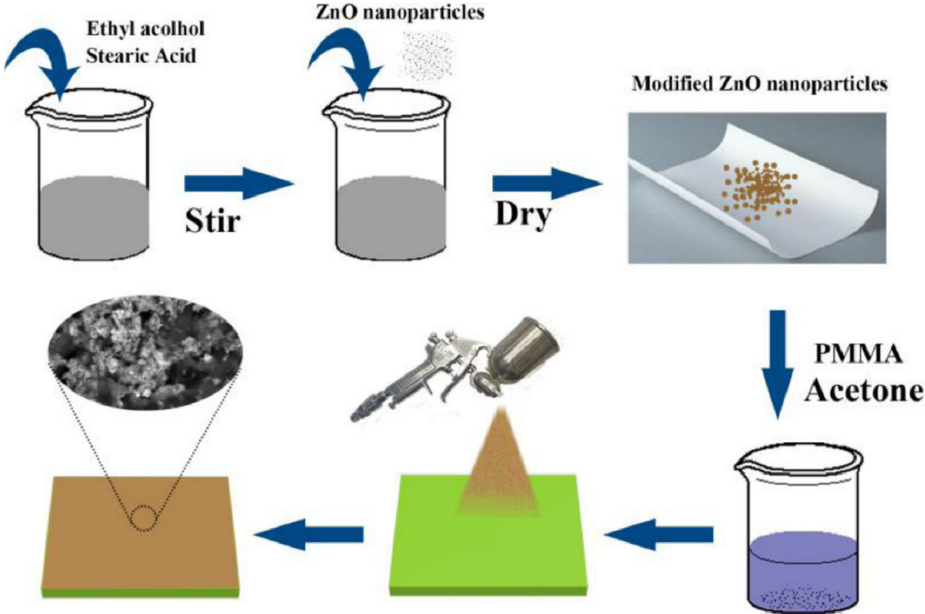
Figure 8. Schematic illustration of the fabricating process. Reprinted with permission from Ref. [66]. Copyright (2021) Elsevier.